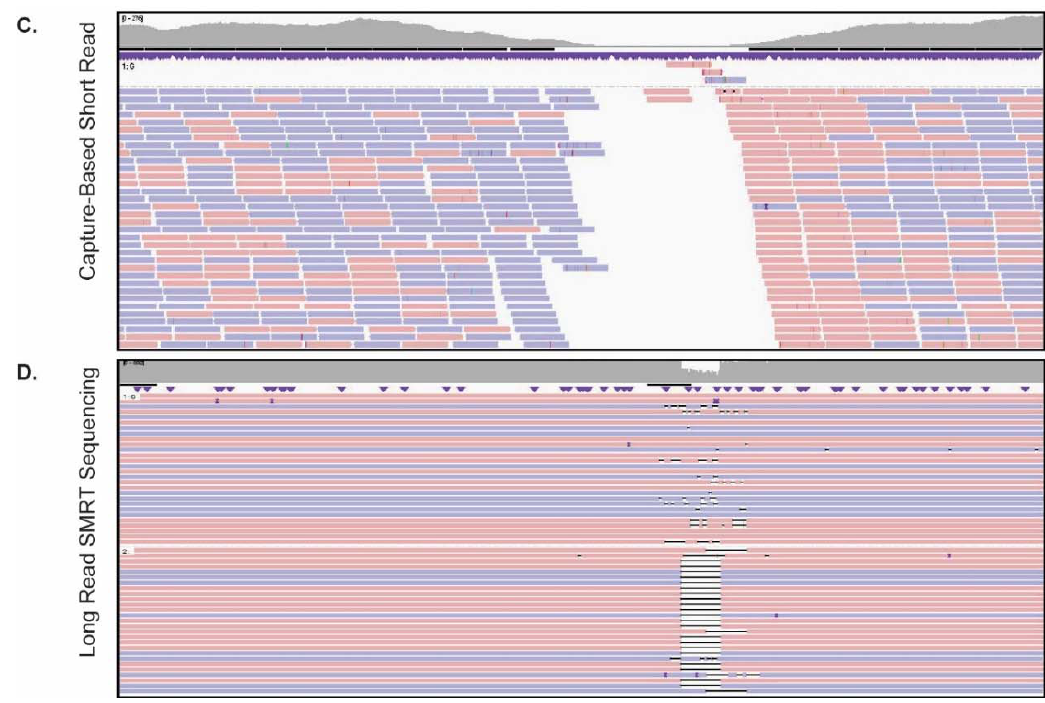
Figure 1. Representative SLC6A4 promoter sequencing of the NA12156 Coriell sample using short-read (Genetic Testing Reference Material Coordination Program (GeT-RM) genome sequencing (WGS), and capture-based sequencing) and long-read single molecule real-time (SMRT) sequencing. Note the inability to interrogate the repetitive SLC6A4 promoter region ( A ) by two short-read sequencing approaches (WGS ( B ) and capture-based sequencing ( C )), in contrast to the 5-HTTLPR short (S) allele detection and haplotype phasing accomplished by long-read SMRT sequencing ( D ). Genes 2020 , 11 , x FOR PEER REVIEW